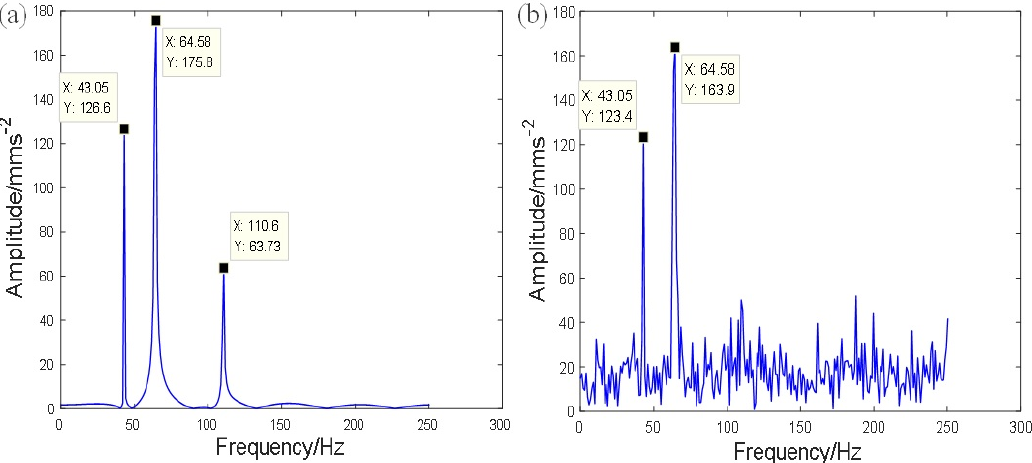
Figure 1. Comparison of frequency spectrums: ( a ) without noise and ( b ) with noise (SNR = 1).